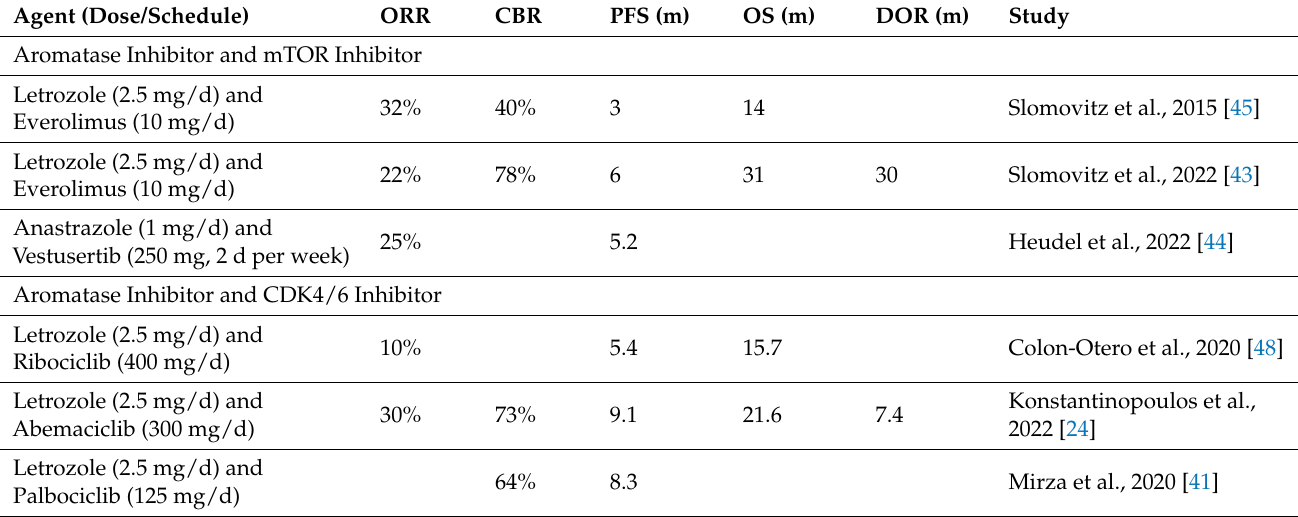
Table 2. Combination hormonal with targeted therapy with efficacy